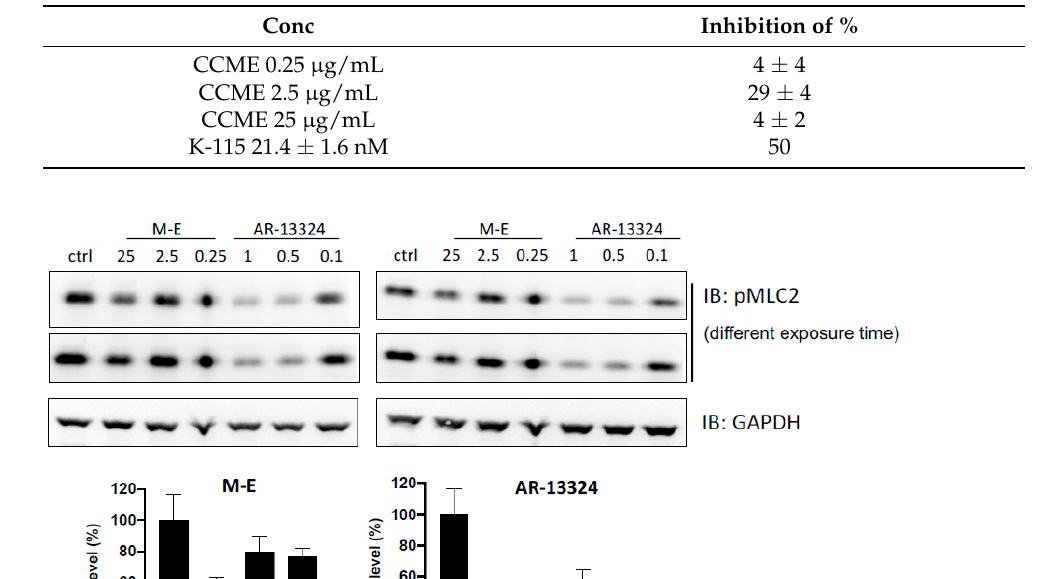
Table 1. ROCK kinase inhibition assay for CCME.